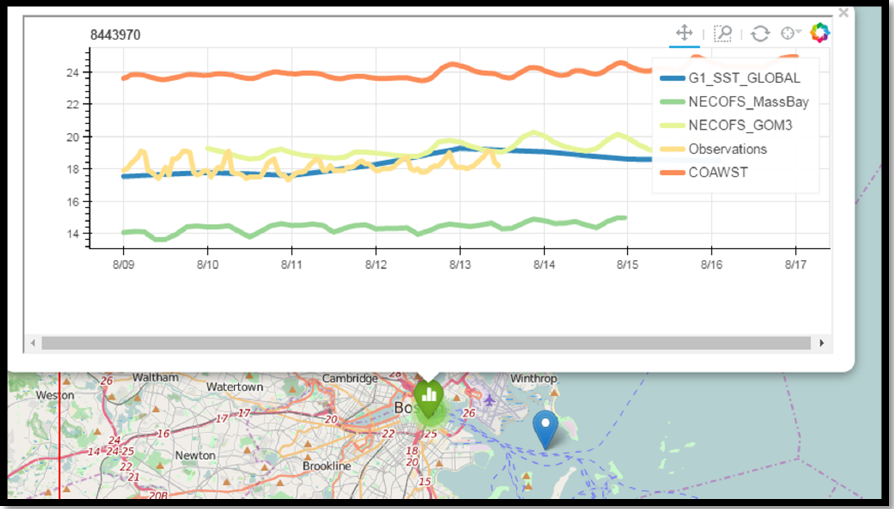
Figure 8. Screenshot from the Map Display notebook, showing the NECOFS_MassBay model about 4 °C colder than observations, and the COAWST model 6 °C warmer than observations. The NECOFS_GOM3 model is within a degree of the in situ observations (as is the G1_SST_GLOBAL global SST product derived from remote sensing).